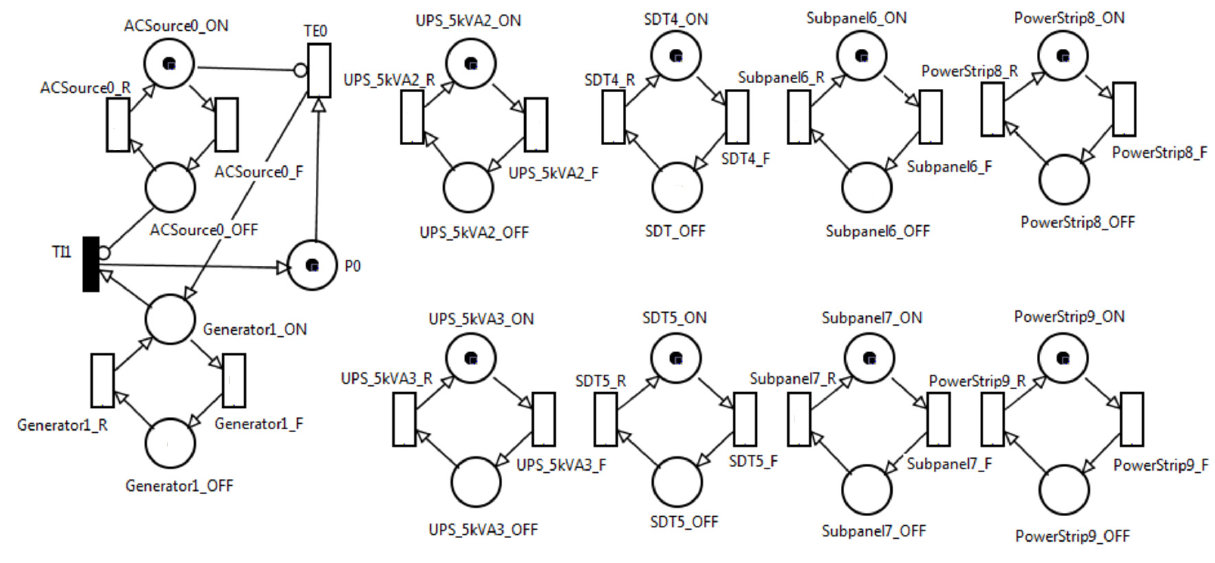
Figure 17. Stochastic Petri net of A6.